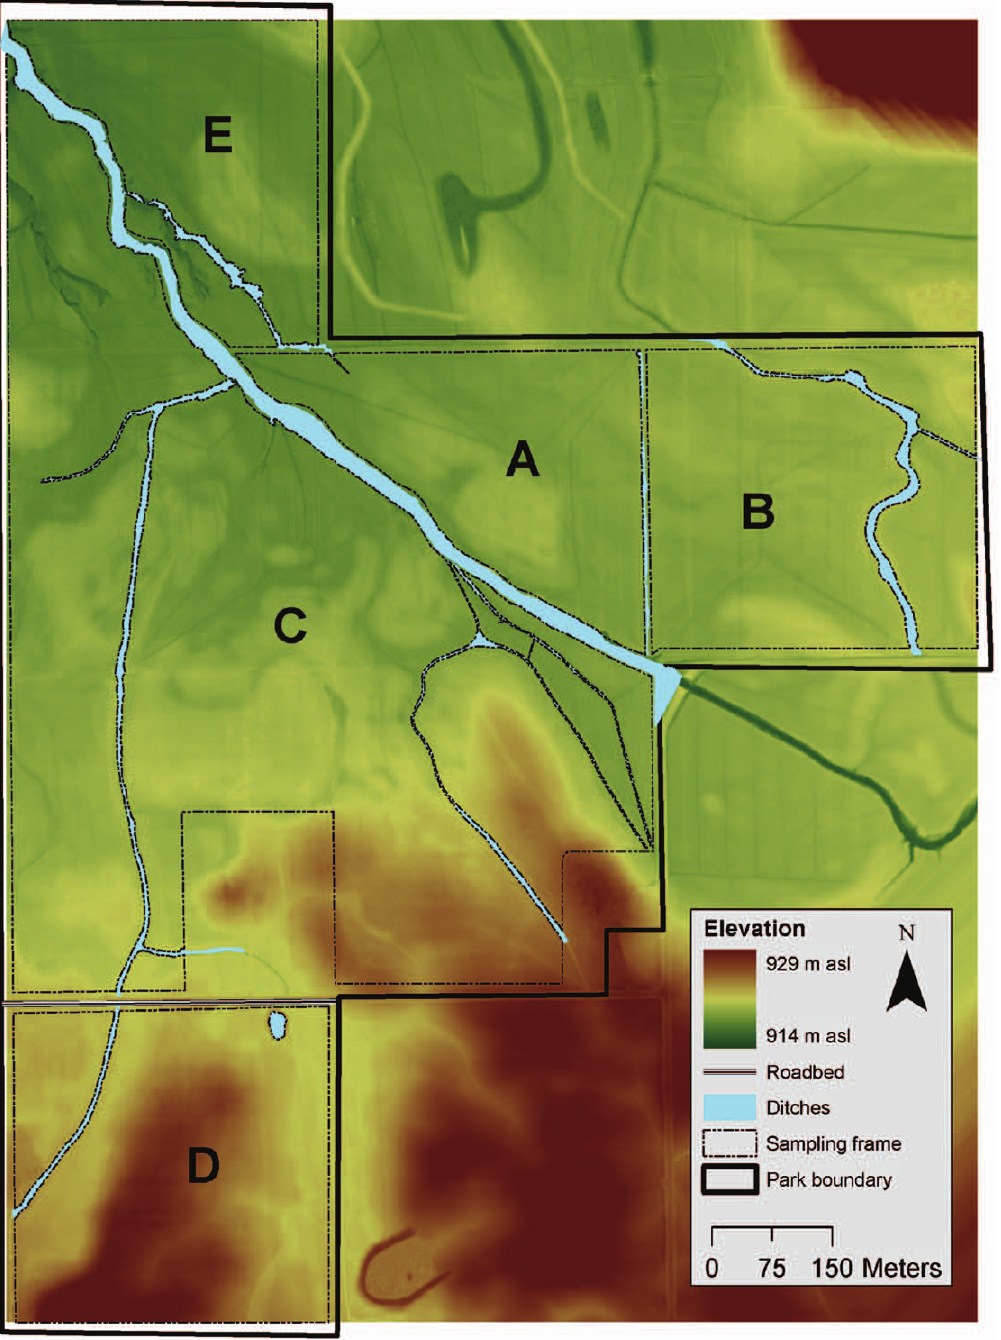
Figure 2. The restoration site, Weippe Prairie, Idaho, USA. The stratified sampling frame identifies 5 zones labeled A–E. A narrow ditch between zone A and B overlaps with the sampling frame boundary and is not readily visible. A paved road separates zone C and D. Elevations were obtained from high-resolution laser altimetry (LiDAR).